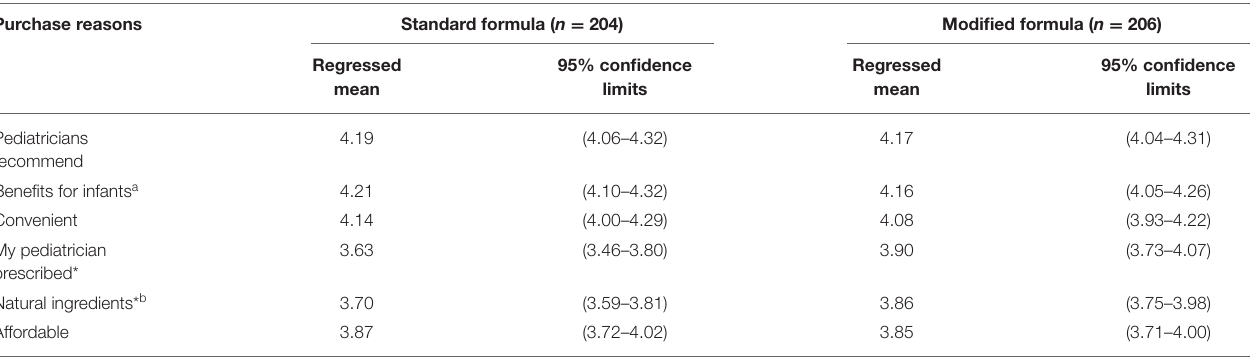
TABLE 2 | Agreement with purchase reasons by formula product category served ( N =